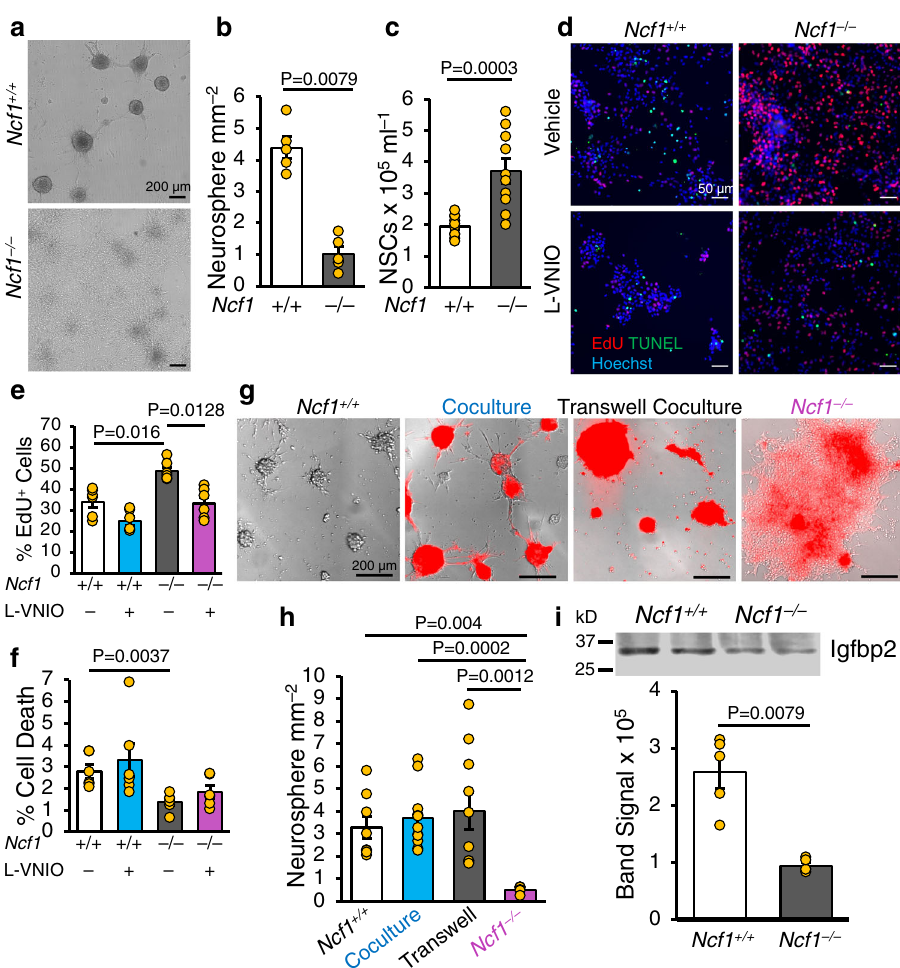
Fig. 1 | The Nox2 subunit Ncf1 facilitates neurosphere formation in a non-cell autonomous manner by regulating Igfbp2 secretion and activity. a – c Non- adherent cultures of primary postnatal forebrain NSCs were established from WT and Ncf1 – / – miceand 2 nd passageNSCs weregrownfor 11days. a Photomicrographs of NSCs after 11 days in culture. b Quanti fi cation of neurospheres ≥ 60 µ m in